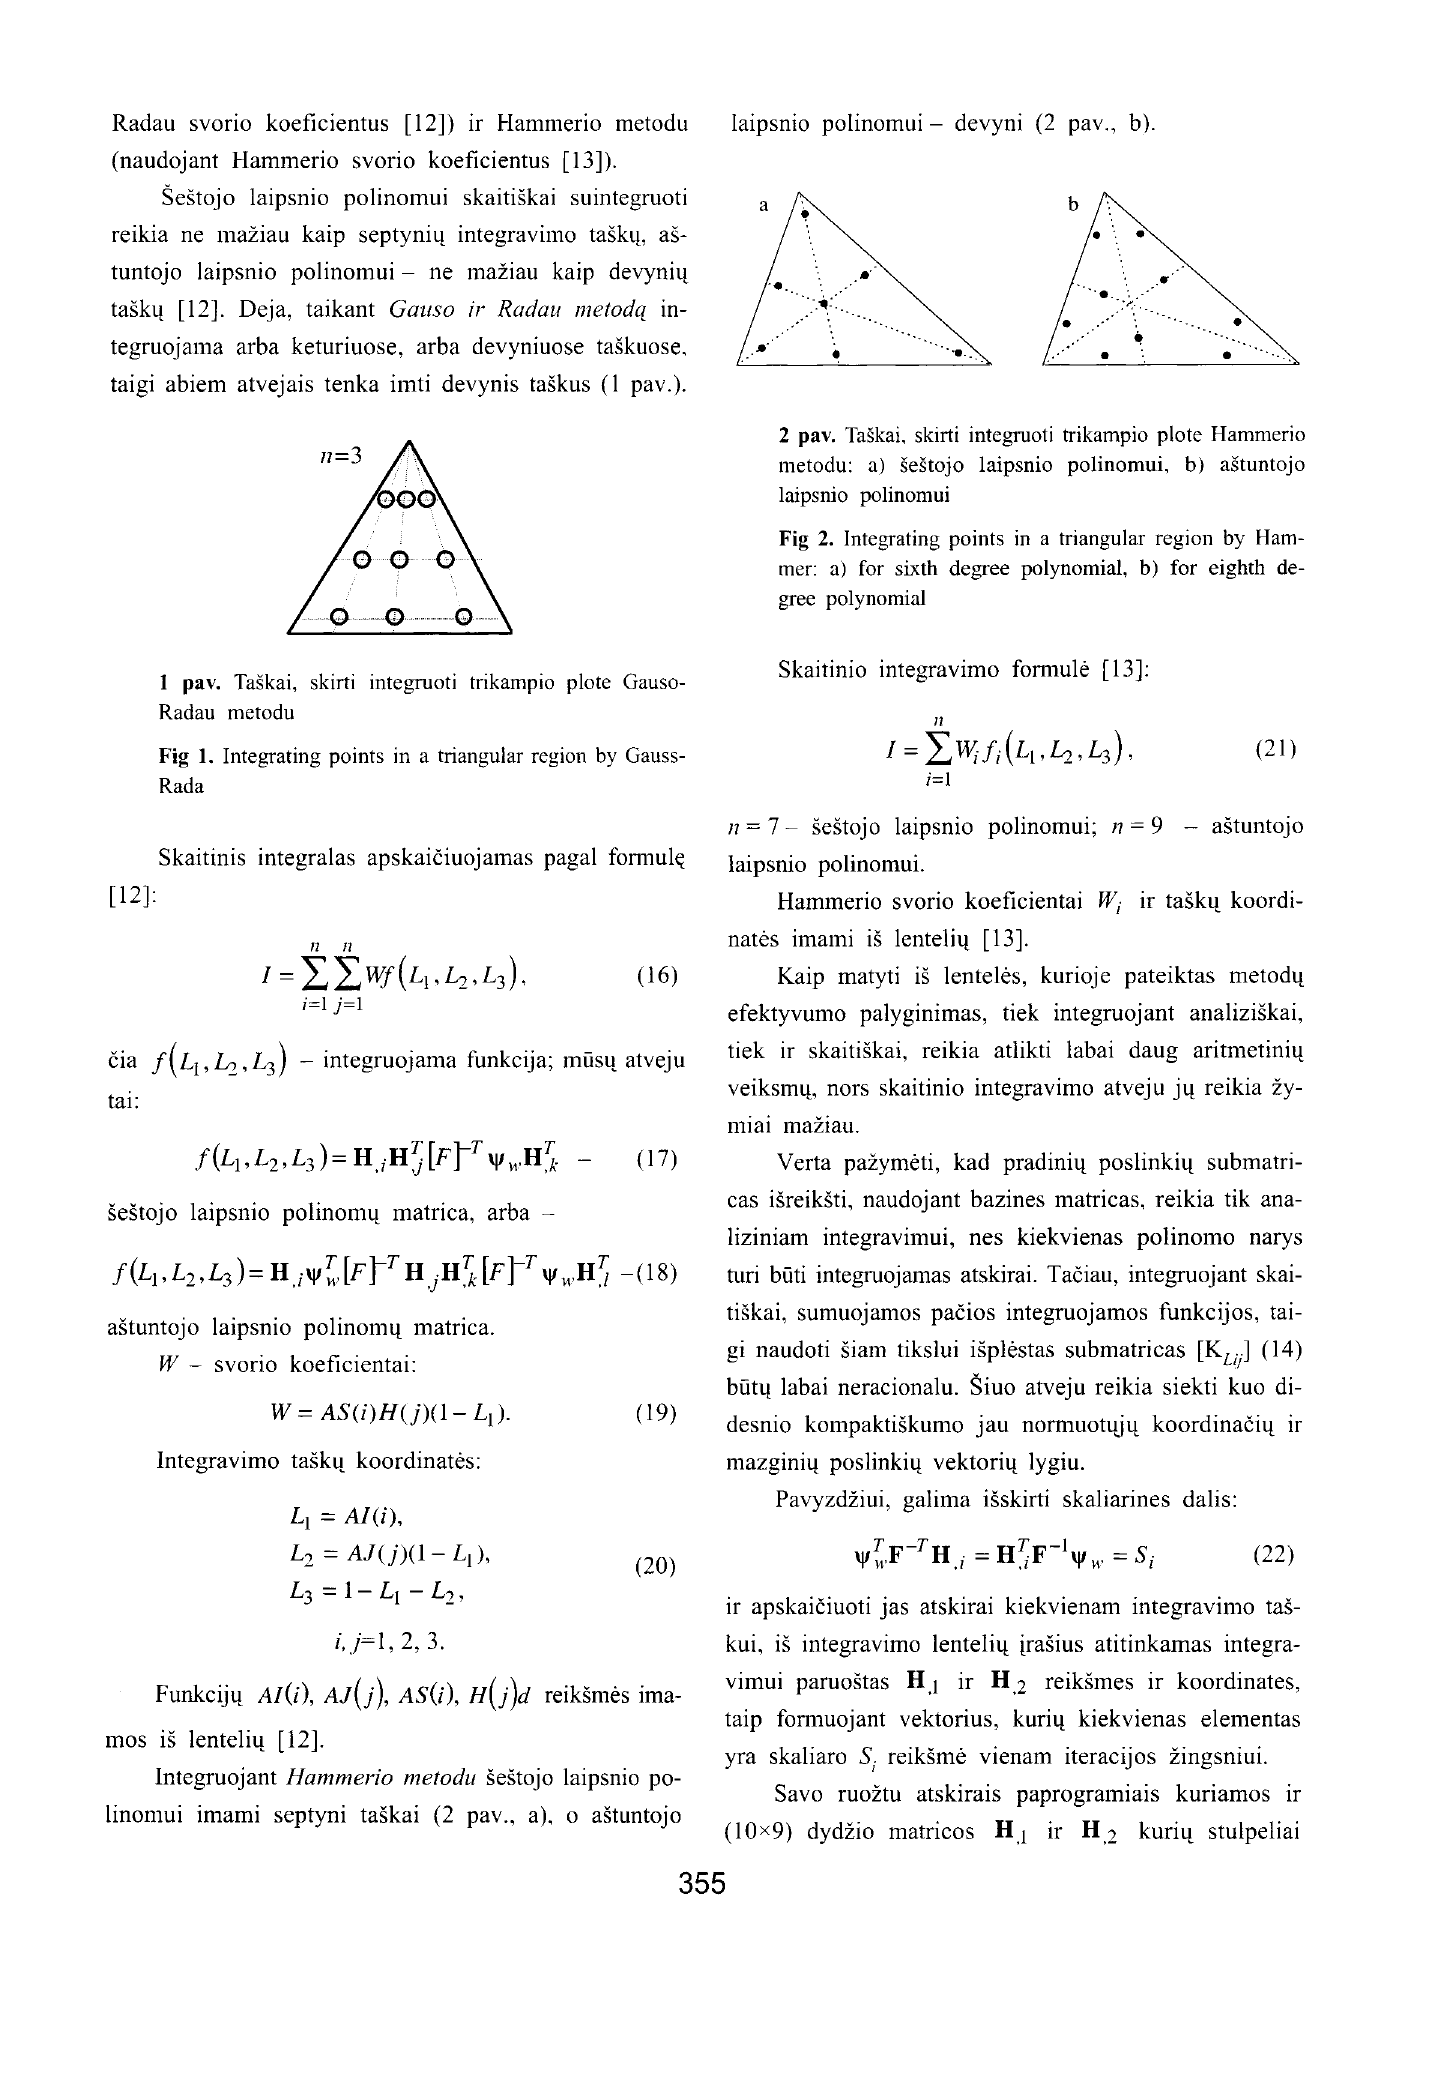
Fig 2. Integrating points in a triangular region by Ham mer: a) for sixth degree polynomial, b) for eighth de gree polynomial Skaitinio integravimo fomm1e